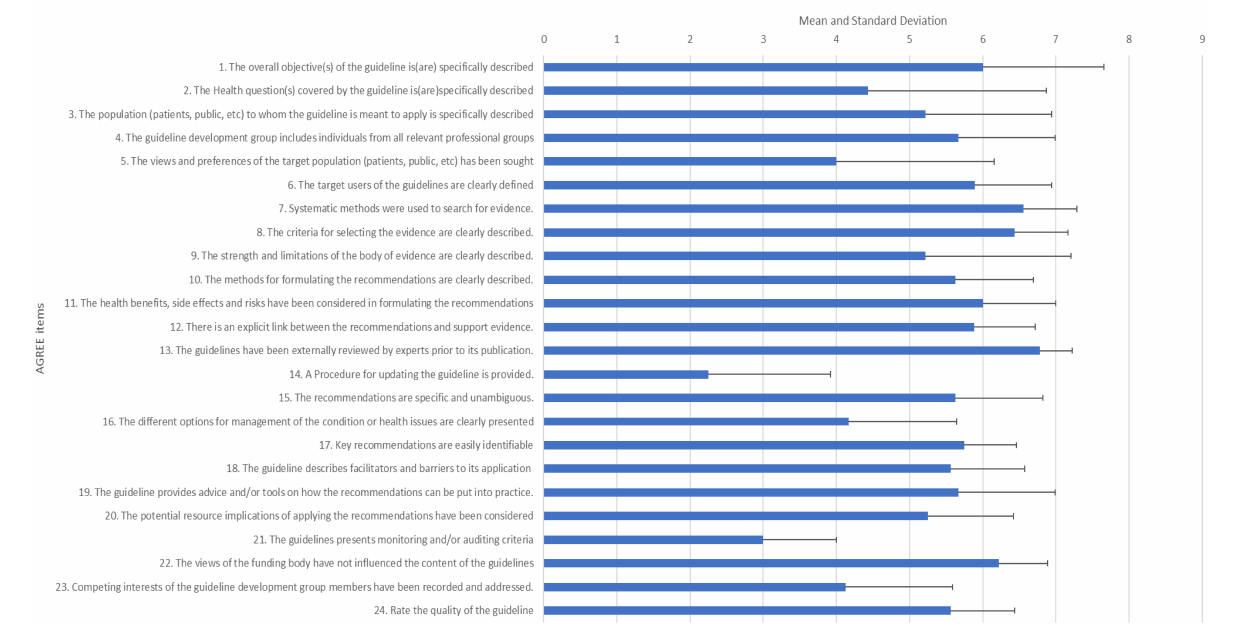
FIGURE 2 | A graphical representation of the means and standard deviations for each AGREE